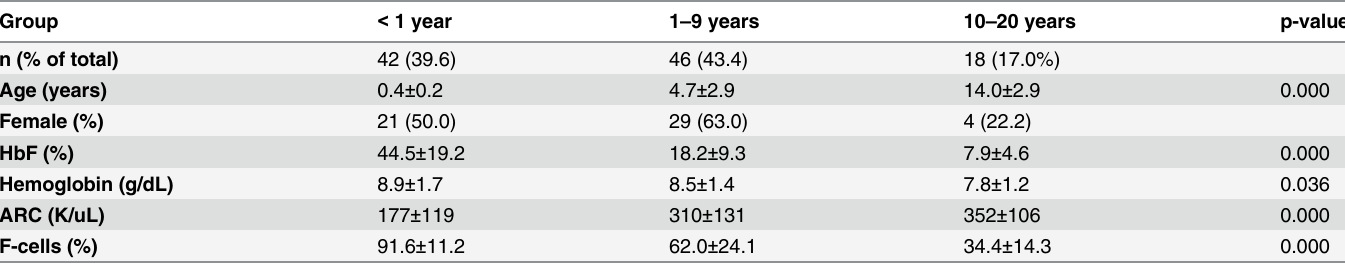
Table 1. Demographic and Hematologic